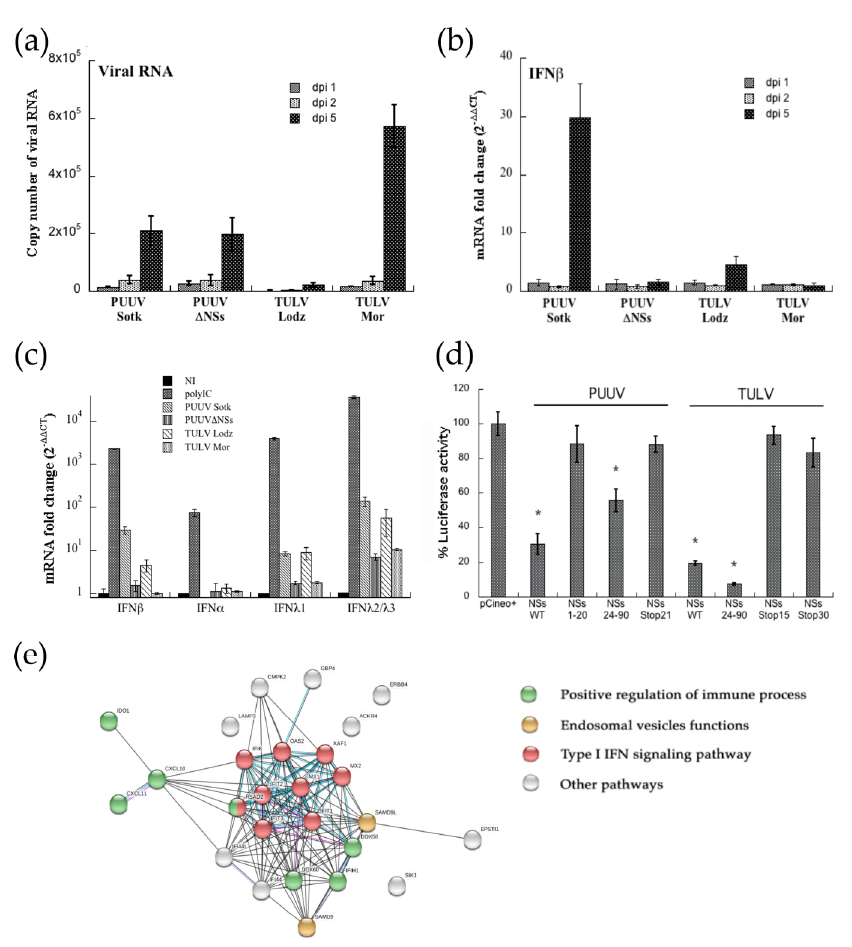
Figure 6. IFN production and networks of interacting genes up-regulated in infected A549 cells. A549 cells, were infected at MOI 0.5 with PUUV or TULV, and their variant forms, defective in expression of a full-length NSs. The histograms correspond to RNA quantified by RT-qPCR and error bars correspond to standard deviation obtained from three independent experiments, evaluating, in ( a ), the number of viral RNA copies in infected A549 cells at dpi 1, 2 and 5, in ( b ), the log2 fold change level as compared to non-infected cells of IFN β mRNA in the same extracts and in ( c ), mRNA expression levels of IFN β , IFN α or INF λ 1 or IFN λ 2/3 at dpi 5 as compared to A549 cells, non-infected, or treated with 1 µ g of poly-IC. In ( d ), mutated NSs constructs with a stop codon in position 21 of PUUV NSs or 15 of TULV NSs as well as NSs fragments covering N-ter or C-ter regions were tested for their capacity to inhibit IFN-Luc activated via RIG-I. Standard deviation and statistics (* = p < 0.05) were obtained from biological triplicates. In ( e ), up-regulated genes that were identified by RNAseq in PUUV infected A549 cells were analyzed while using STRING software. The edges of known interactions in the network appear in light blue for curated data and in pink for experimentally determined interactions, while black lines correspond to interaction of correlated genes and violet to genes sharing orthology. Relevant nodes are colored, as indicated in the